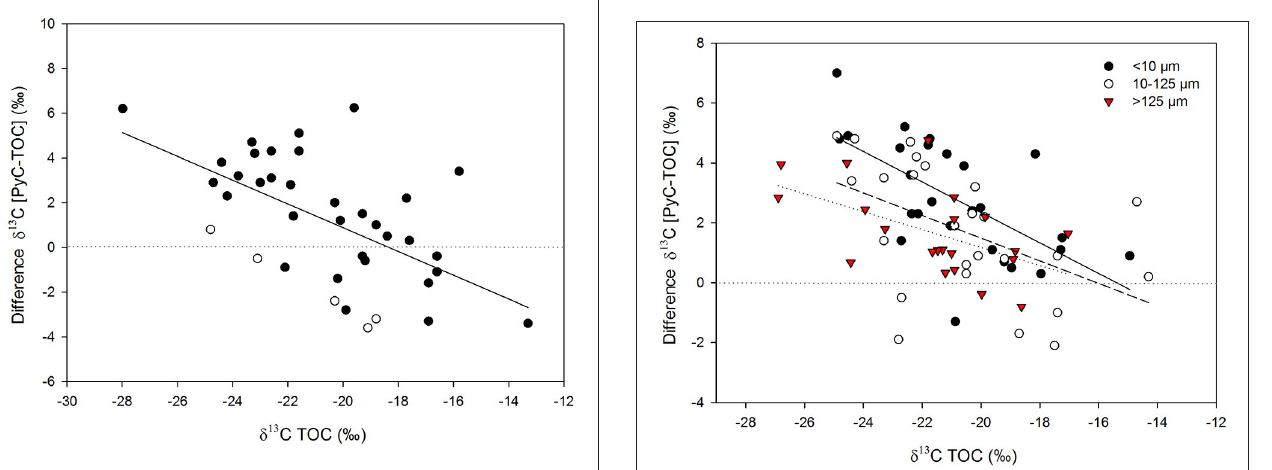
FIGURE 5 | Relationship between δ 13 C values of bulk sediment samples and differences in δ 13 C between the PyC component and the TOC pool; r 2 0.34; p < 0.05. Open symbols correspond to samples with very coarse texture ( n = 5).